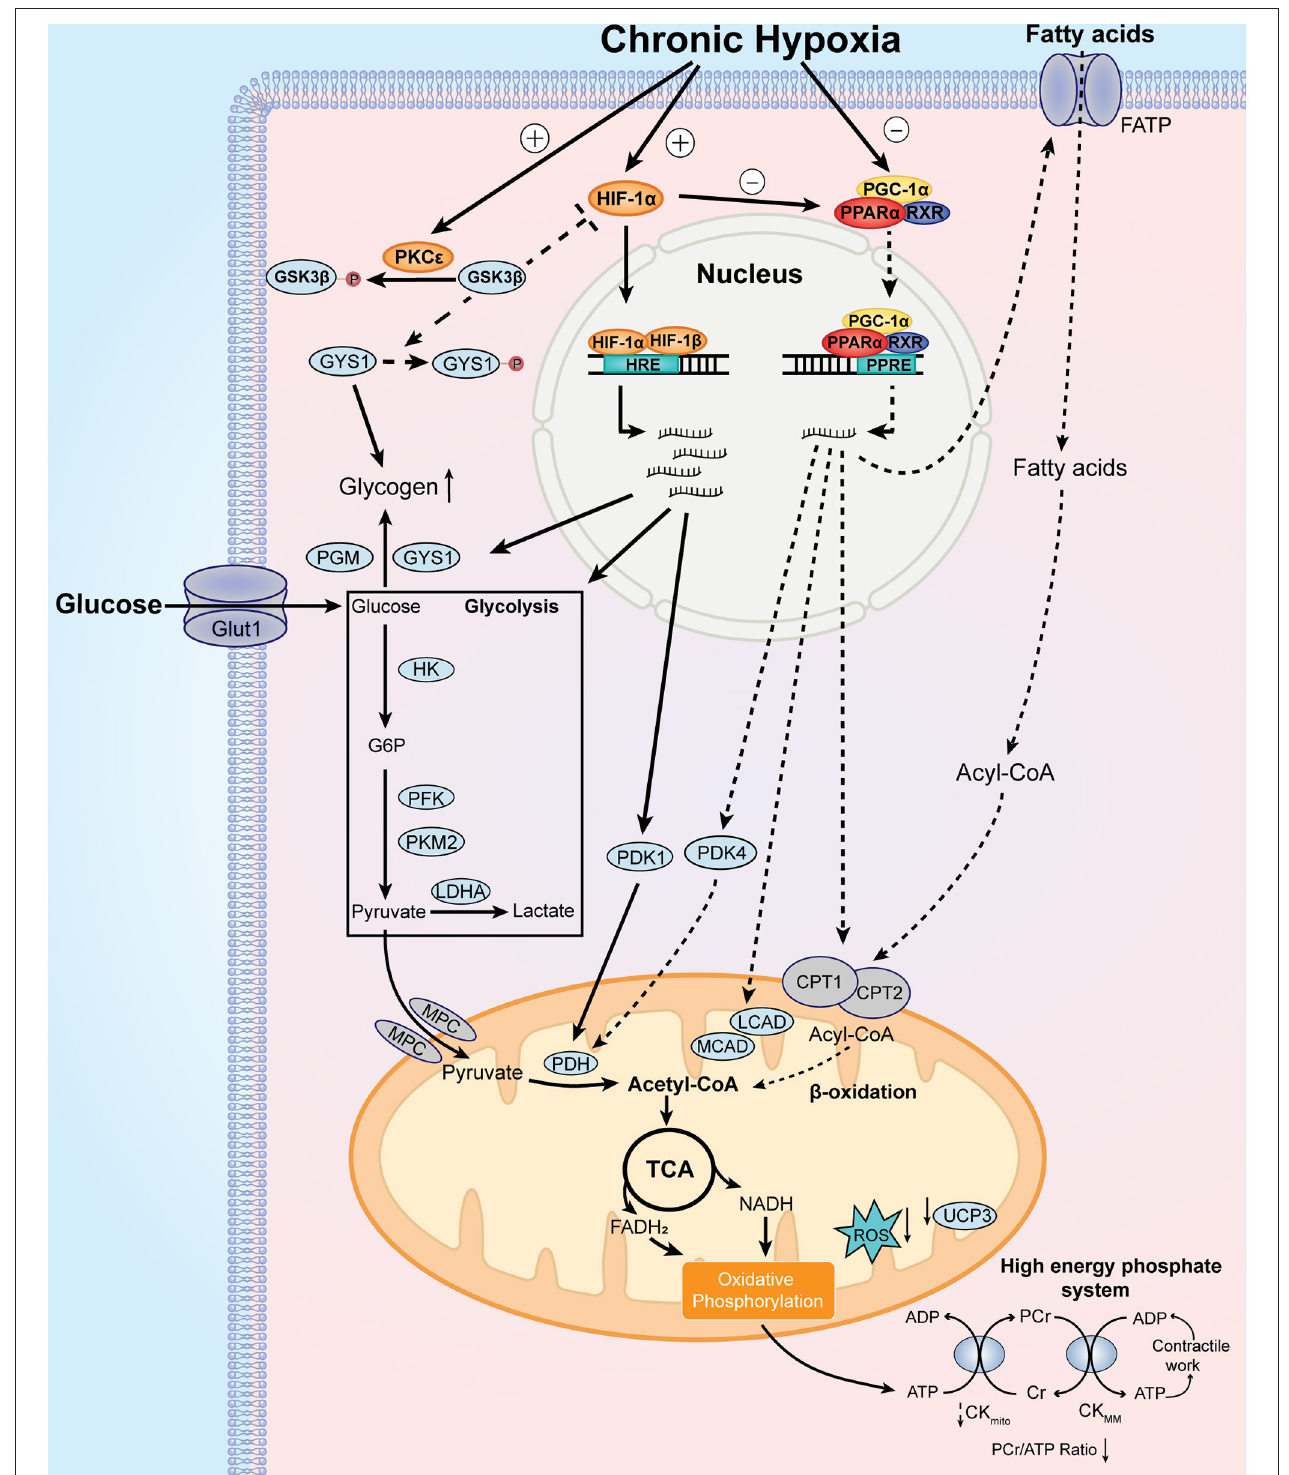
FIGURE 2 | Major features and mechanistic basis of the adaptive cardiac metabolism under chronic hypoxia. Chronic hypoxia leads to increased level and stabilization of HIF-1 α , which upregulates the expression of glucose transporter 1 (GLUT1), hexokinase (HK), phosphofructokinase (PFK), pyruvate kinase isozyme M2 (PKM2), lactate dehydrogenase A (LDHA), pyruvate dehydrogenase kinase 1 (PDK1), glycogen synthase 1 (GYS1), and phosphoglucomutase (PGM). These changes lead to increase in glucose uptake, glycolysis, and glycogen synthesis. Additionally, chronic hypoxia decreases PPAR α and PGC-1 α levels, which decrease fatty